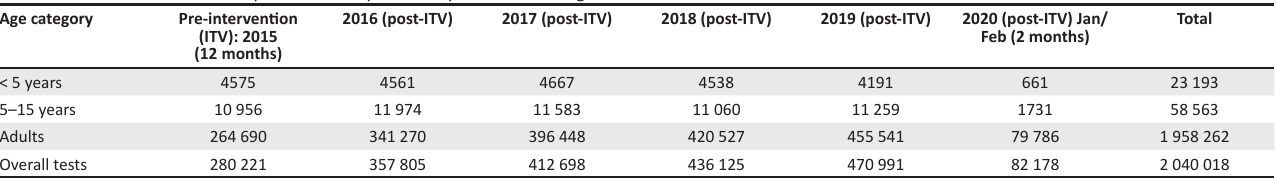
TABLE 1: Number of viral loads captured annually in the City of Johannesburg before and after the intervention. Age category Pre-intervention (ITV): 2015 (12